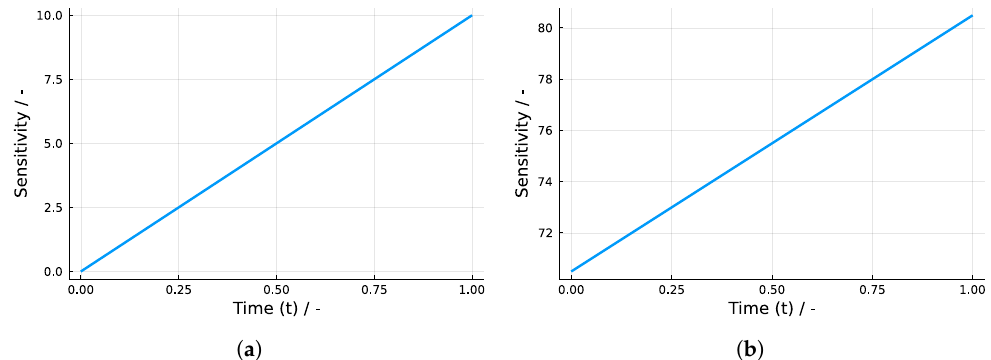
Figure 8. Parameter sensitivity of the diffusion parameter κ for Scenario 2 assuming a boundary control problem with ( a ) using OLS to define the parameter identification problem and ( b ) where ILS is used to define the parameter identification problem